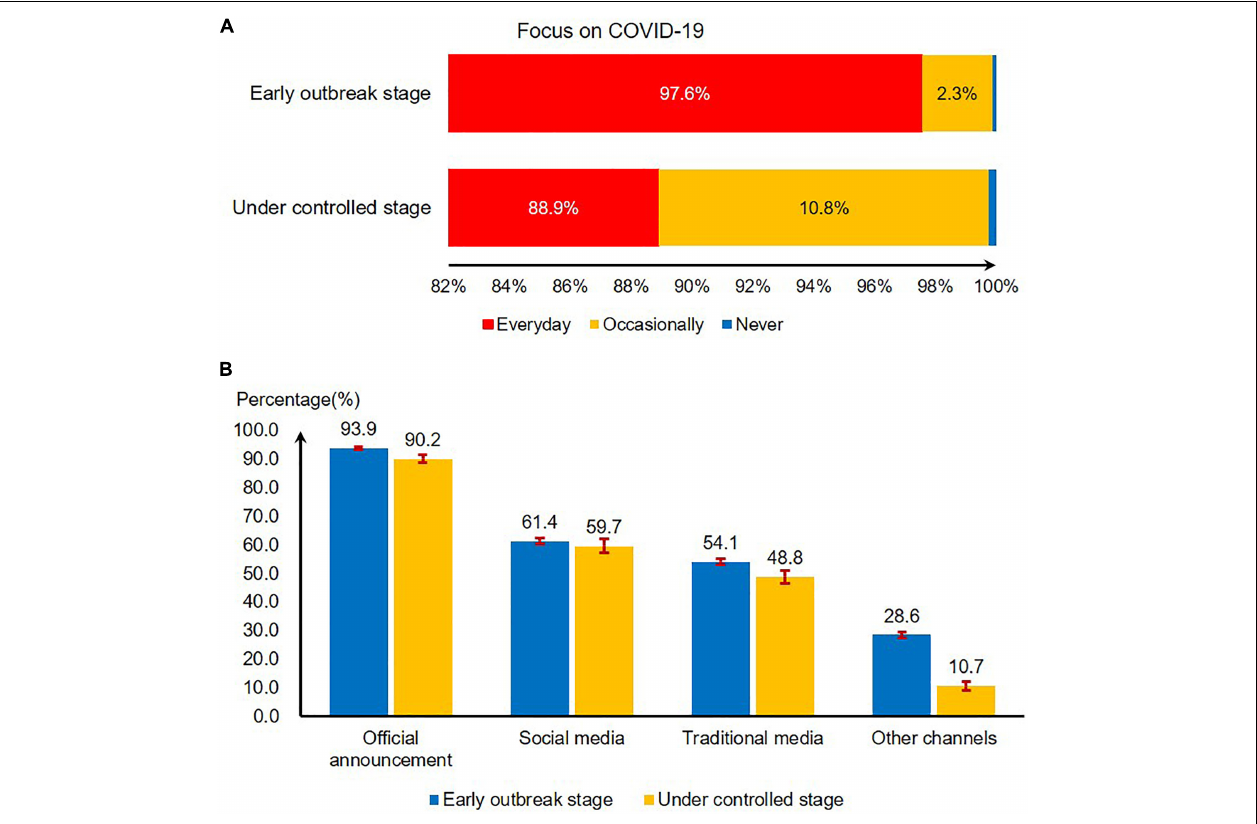
FIGURE 2 | The changes of people’s attention and channel preference for COVID-19 outbreak information when COVID-19 was early and under control in China, 2020. (A) People’s attention to COVID-19 when COVID-19 was early and under control in China, 2020. (B) Channel preference for COVID-19 outbreak information reporting and seeking when COVID-19 was early and under control in China, 2020.